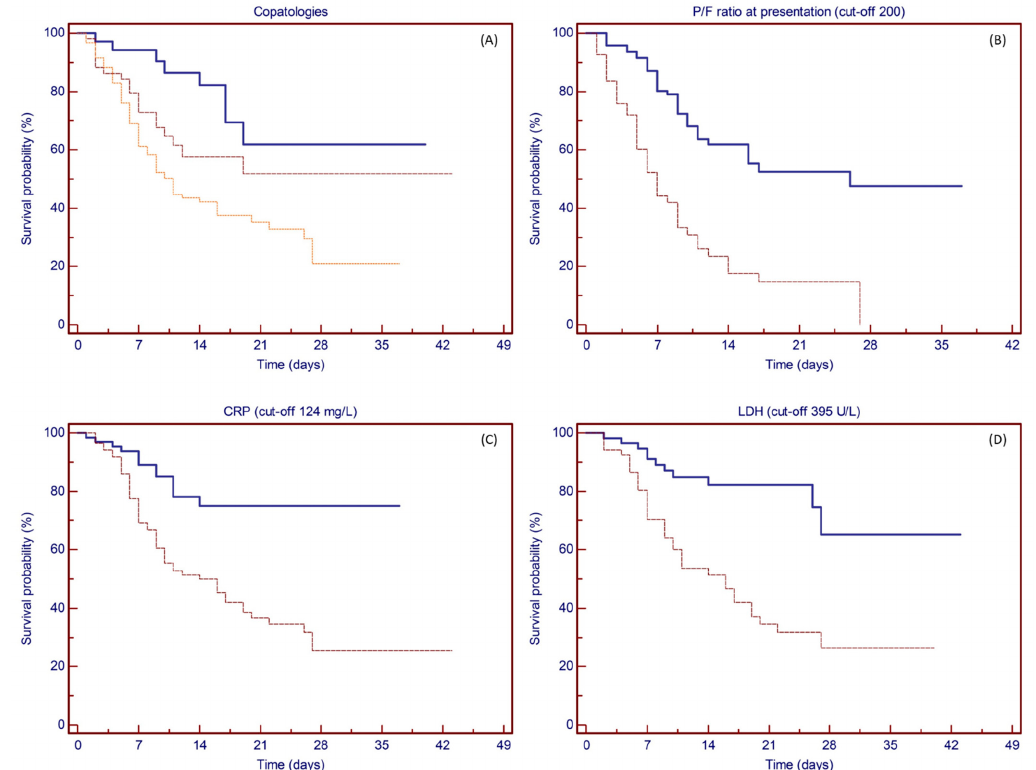
Figure 3. Kaplan–Meier plots showing the probability of survival based on clinical variables. ( A ) Patients with no comorbidity (solid line), 1 comorbidity (dashed line), and 2 or more comorbidities (dotted line). The number of comorbidities showed prognostic significance for survival ( p = 0.0008), with an estimated 28-day survival rate of 61.8%, 51.7%, and 35.3%, respectively. ( B ) P/F ratio at presentation more than 200 (solid line) or less than or equal to 200 (dashed line). P/F ratio at presentation showed prognostic significance for survival at a cut-off point set at 200 ( p < 0.0001), with an estimated 21-day survival rate of 52.4% and 14.7%, respectively. ( C ) CRP less than 124 (solid line) or more than or equal to 124 (dashed line). CRP values showed prognostic significance for survival at a cut-off point set at 124 mg/L ( p = 0.0001), with an estimated 28-day survival rate of 74.9% and 25.4%, respectively. ( D ) LDH less than 395 (solid line) or more than or equal to 395 (dashed line). LDH values showed prognostic significance for survival at a cut-off point set at 395 U/L ( p = 0.0001), with an estimated 28-day survival rate of 65.3% and 26.4%,